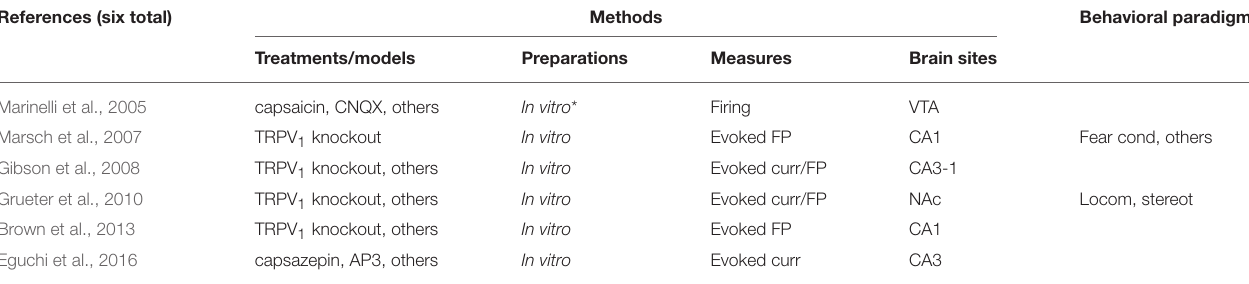
TABLE 2 | Rodent electrophysiology studies involving the endovanilloid system and schizophrenia-relevant treatments/models. References (six